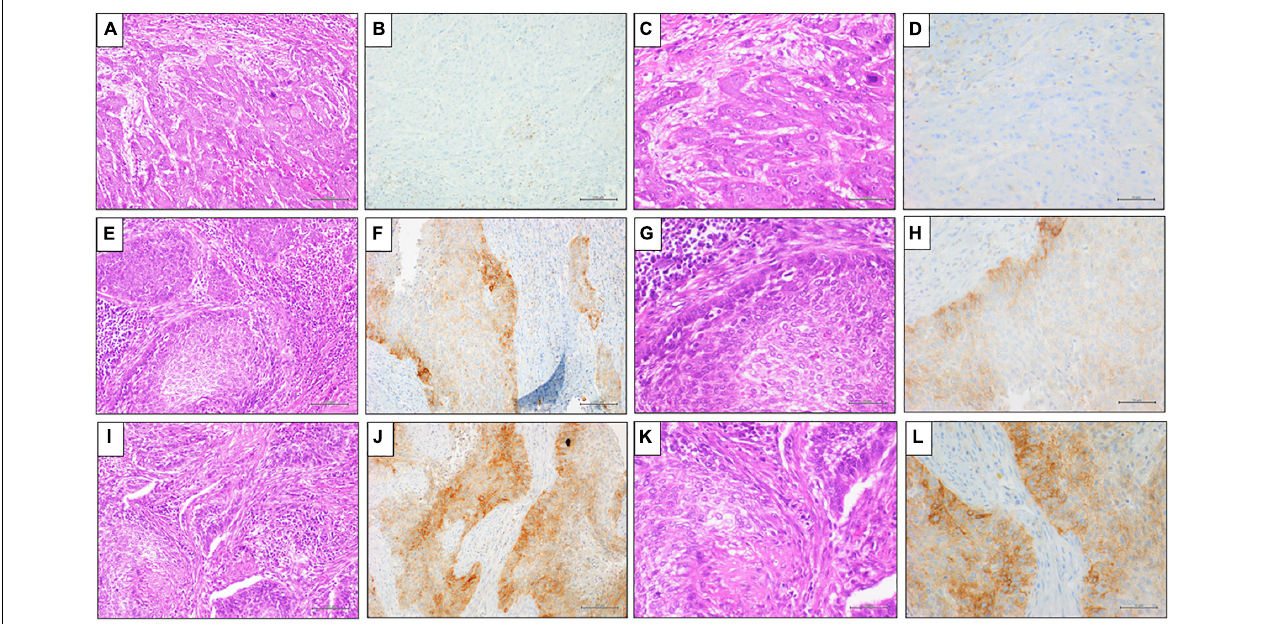
FIGURE 1 | Representative results of PD-L1 (clone SP263) IHC expression by TPS in penile SCC. (A,E,I) Hematoxylin and Eosin (H&E) staining (20x magnification, scale bar 100 µ m); (C,G,M) Hematoxylin and Eosin (H&E) staining (40x magnification, scale bar = 200 µ m); (B,D) PD-L1 (clone SP263) IHC expression < 1%, DAB staining (40x magnification, scale bar = 200 µ m); (F,H) PD-L1 (clone SP263) IHC expression 1% ≤ score < 50%, DAB staining (40x magnification, scale bar = 200 µ m); (L,N) PD-L1 (clone SP263) IHC expression ≥ 50%, DAB staining (40x magnification, scale bar = 200 µ m).